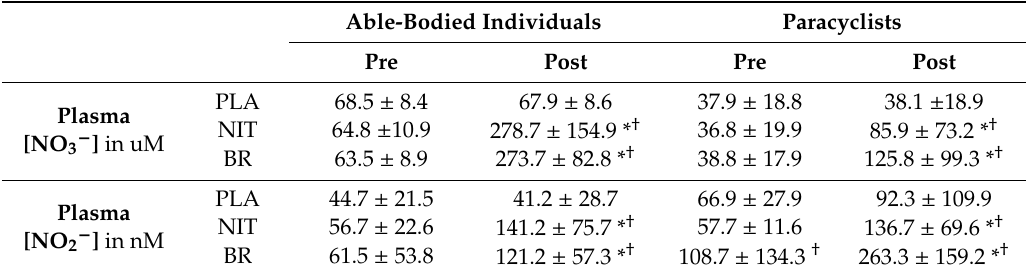
Table 3. Plasma [NO 3 − ] and [NO 2 − ] in able-bodied individuals and paracycling pre and post ingestion of BR, NIT, and